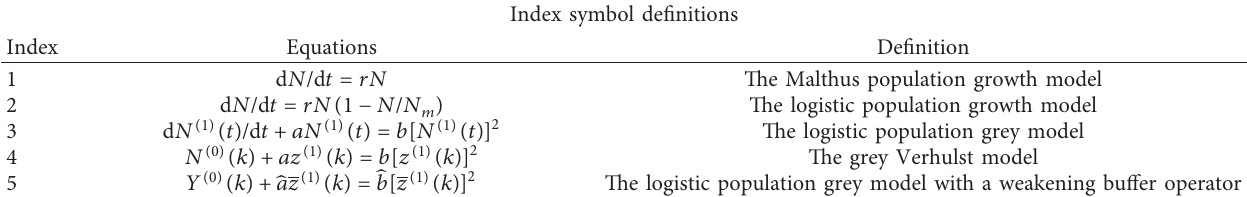
Table 2: Symbols and their